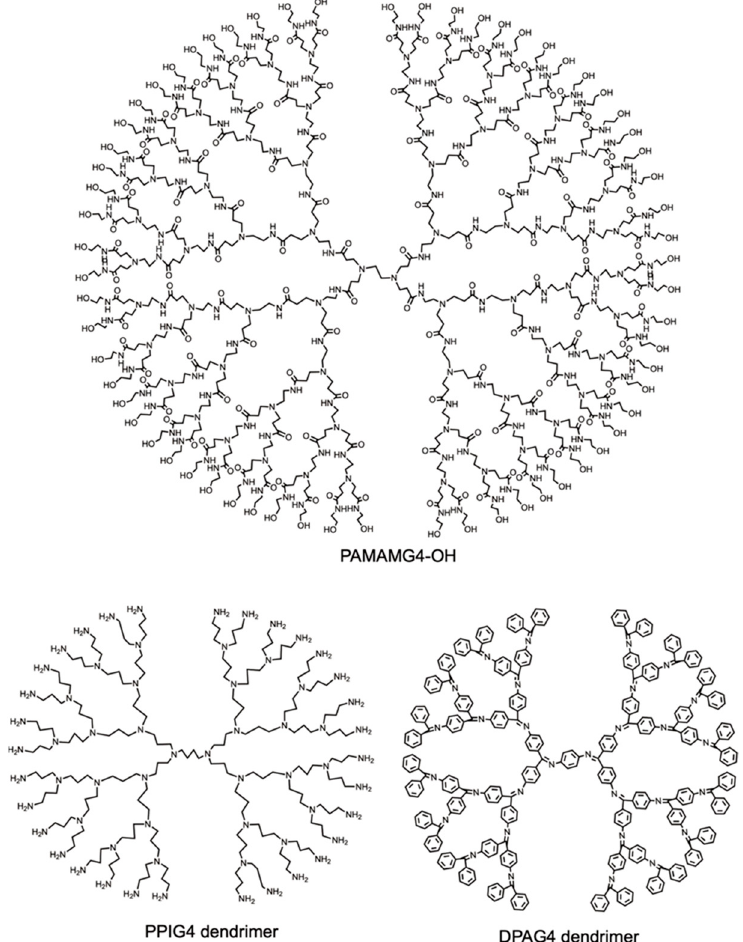
Figure 25. Typical, nitrogen ligand containing, symmetrical branch cell dendrimers suitable for metal salt and metal cluster encapsulations including: ( a ) G4-poly(amidoamine) (PAMAM), ( b ) G3-poly (propylenimine) (PPI) and ( c ) G-4-poly(phenylazomethine) (DPA) dendrimers. Reprinted with permissions from [84]. Copyright 2019 American Chemical Society.